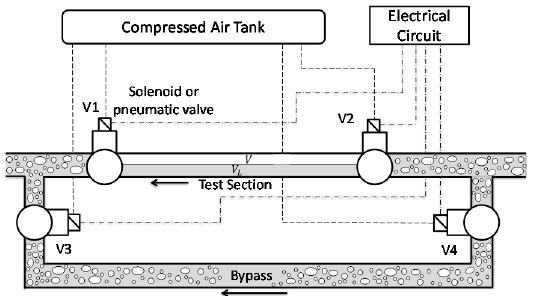
Figure 1. Measurement of void fraction based on quick-closing valves.